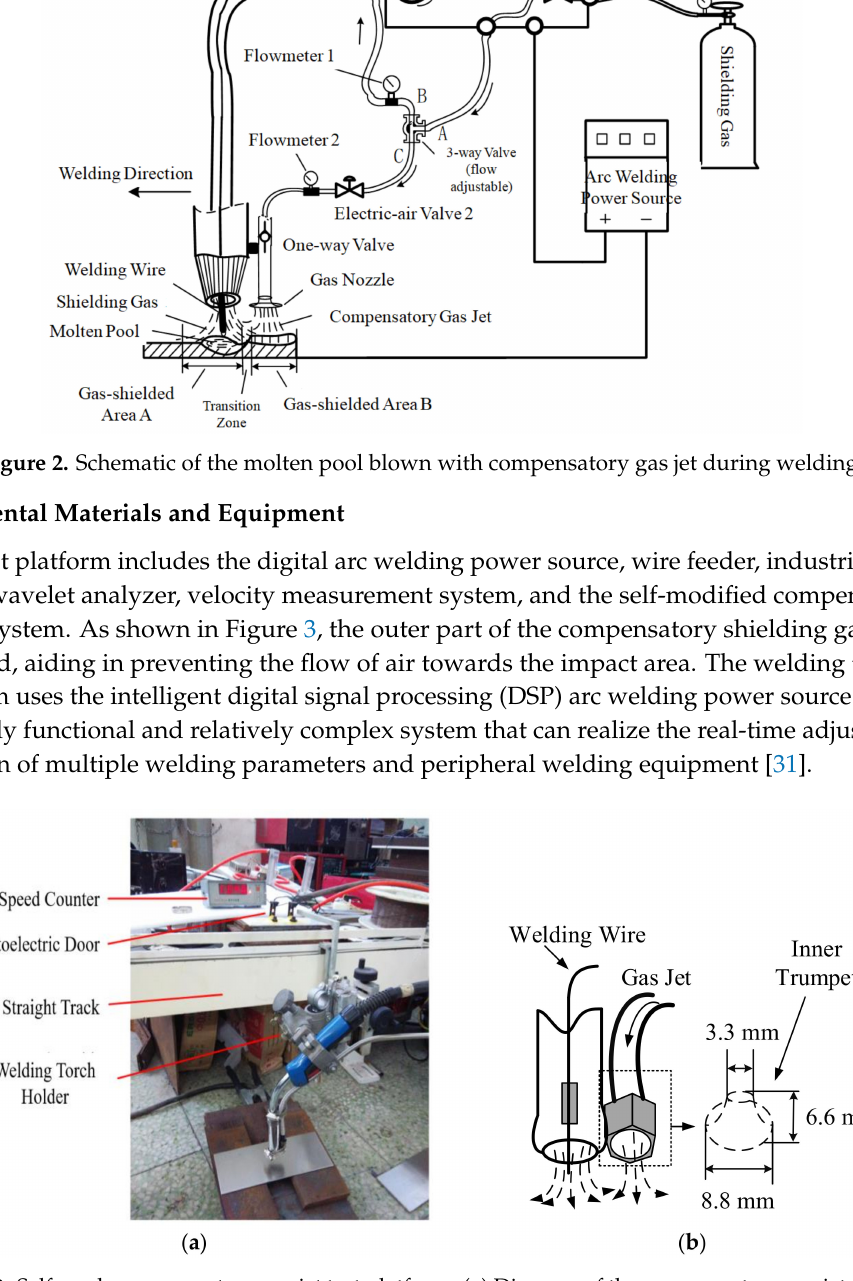
Figure 3. Self-made compensatory gas jet test platform: ( a ) Diagram of the compensatory gas jet system; ( b ) diagram of compensatory gas jet nozzle